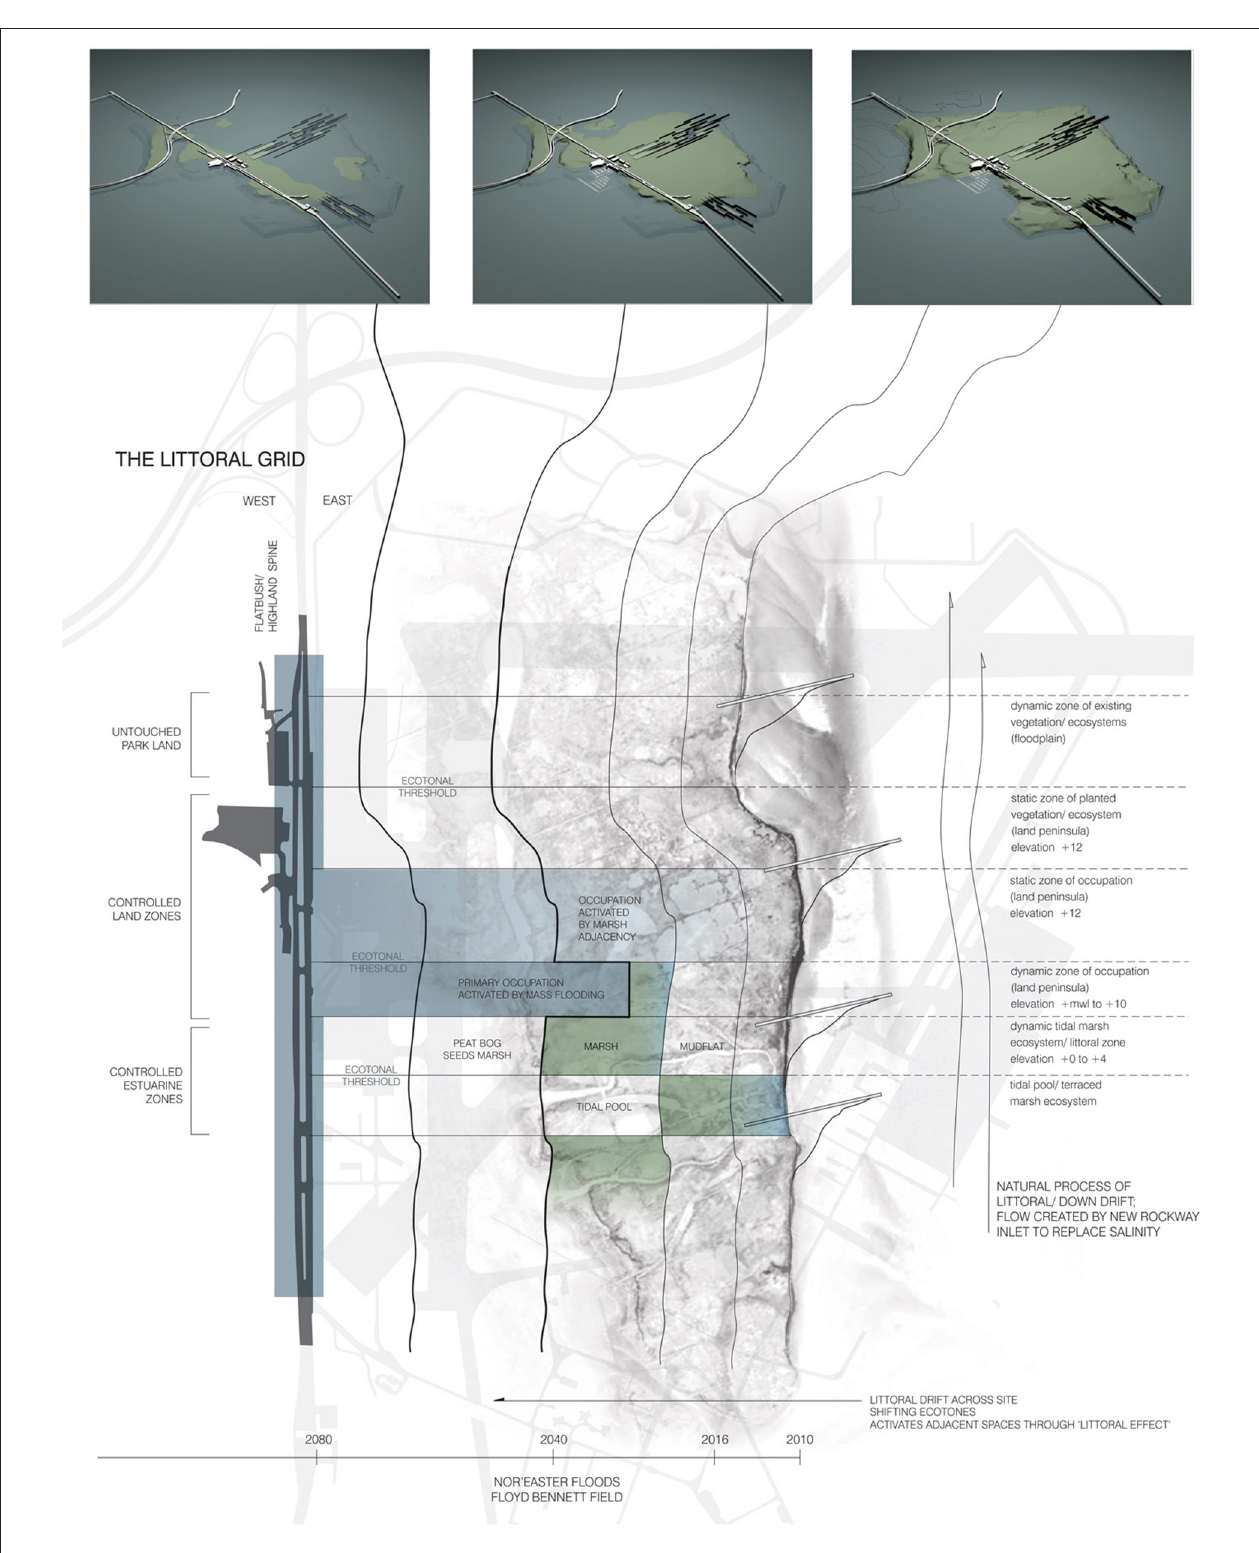
FIGURE 5 | ECOTONES, the winning design of the Van Alen Institute’s Envisioning Gateway design competition for Jamaica Bay by Ashley Kelly and Rikako Wakabayashi. Illustration by Ashley Kelly and Rikako Wakabayashi and used with permission.